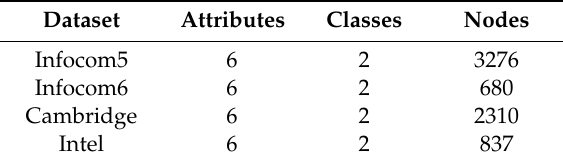
Table 1. Description of the datasets used in the experiment.